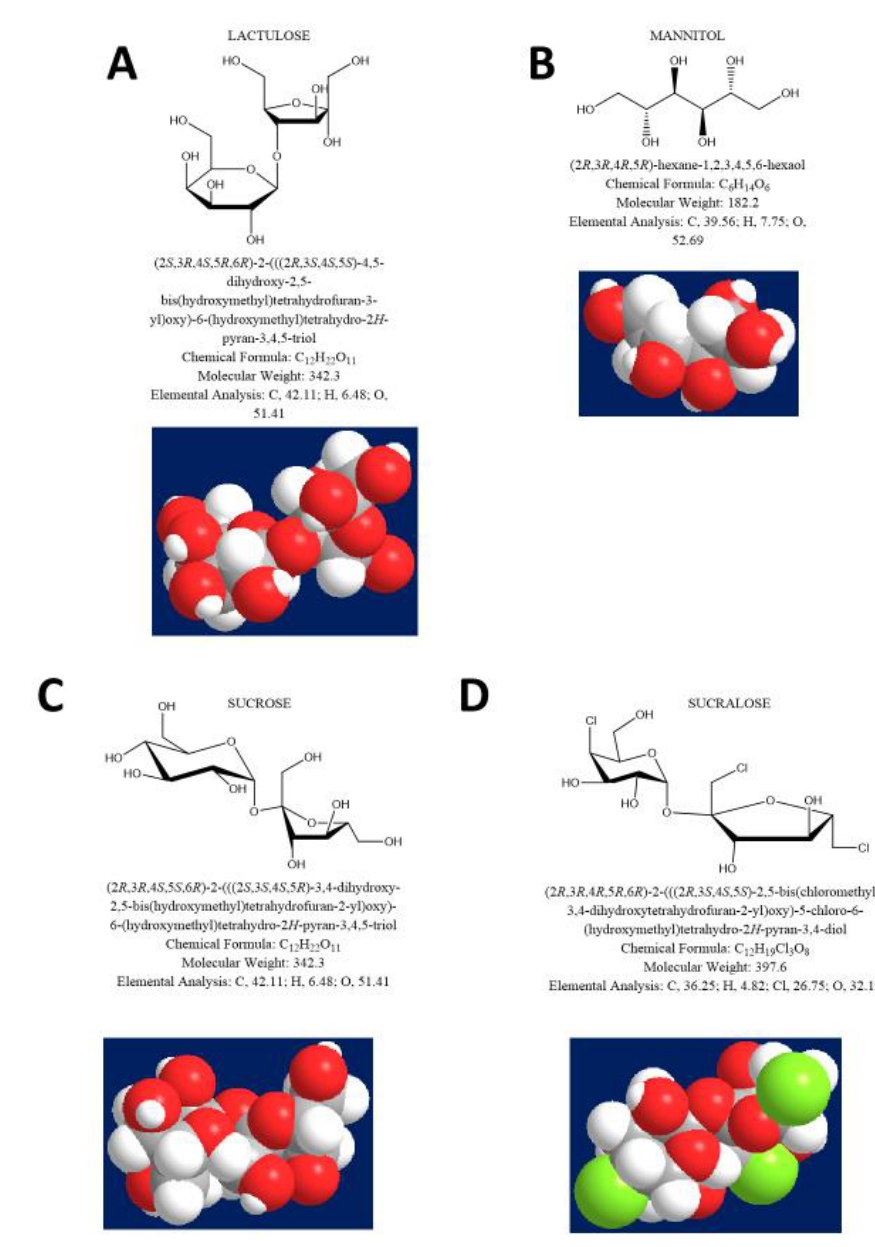
Figure 1. Chemical and 3-D formulas of the sugar probes used for the study of intestinal permeability at different tracts: Lactulose ( A ), mannitol ( B ), sucrose ( C ) and sucralose ( D ).